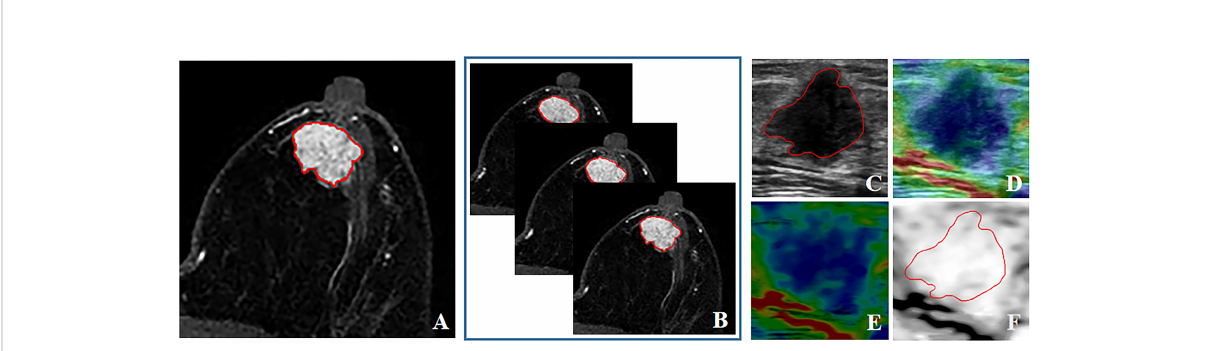
FIGURE 2 The contours for the same lesion between three imaging modalities of a typical patient. (A) DCE-2D; (B) DCE-3D; (C) BMUS; (D) SE elastogram, displayed as a translucent color elastographic image superimposed on the corresponding BMUS image; (E) Pure color elasticity image, obtained by subtracting the BMUS from the SE elastogram; (F) Pure gray-scale elasticity image, the contour was mapped from